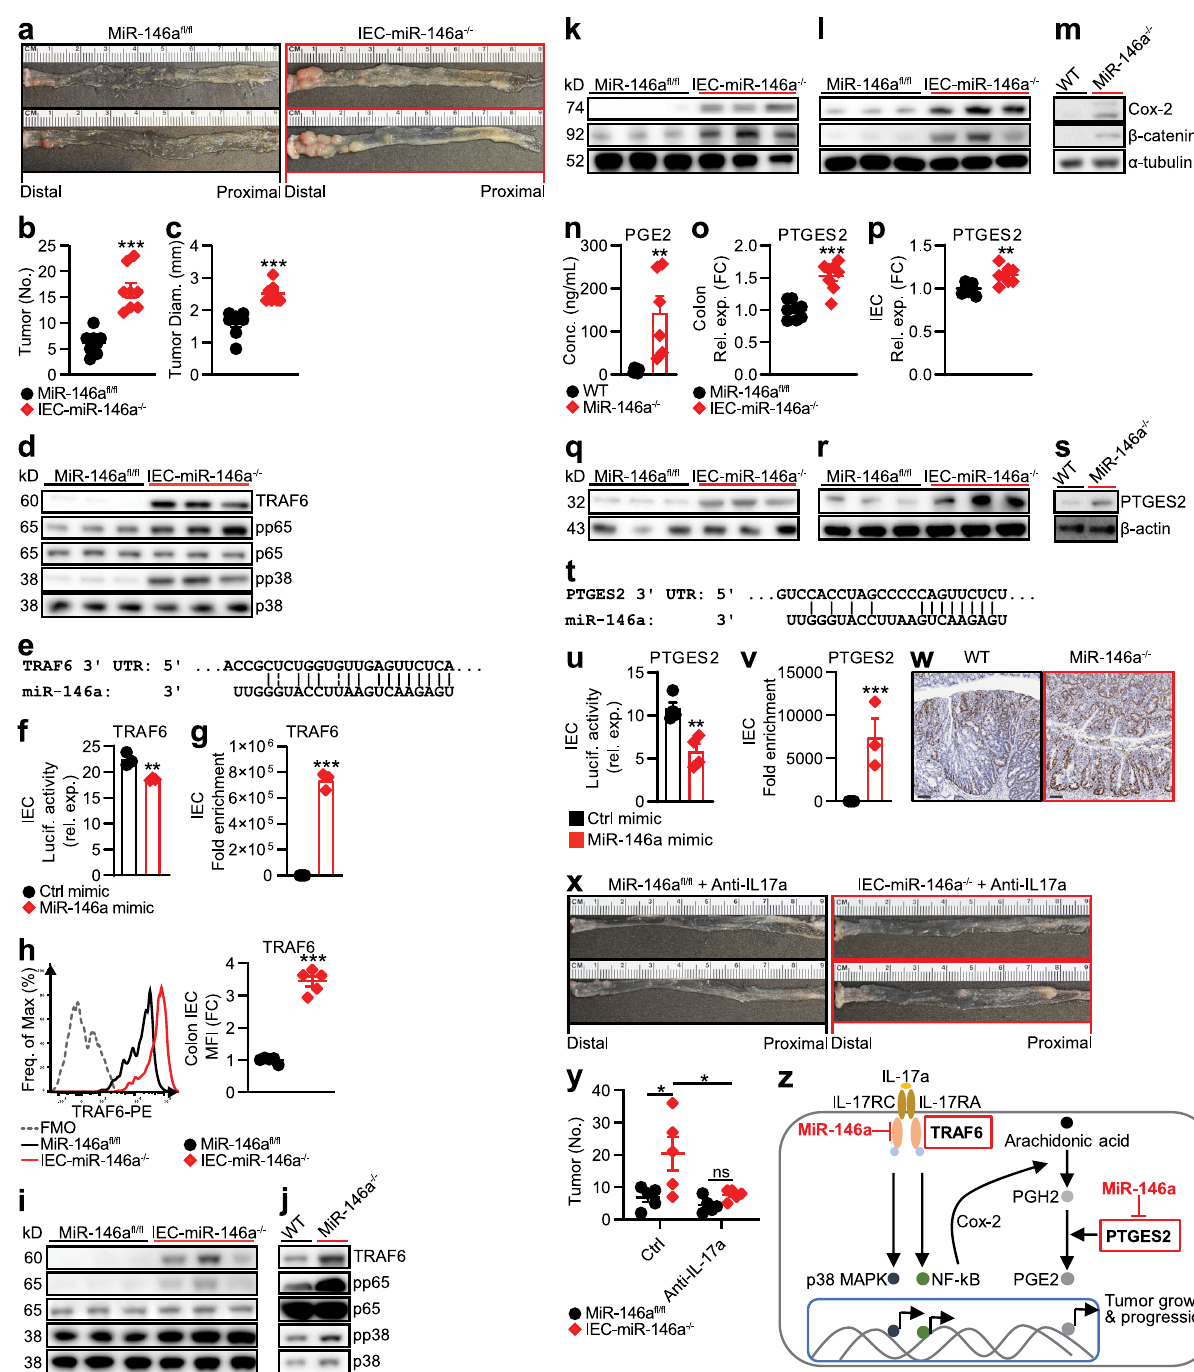
interlinked mechanisms: (1) preventing NF- κ B and p38